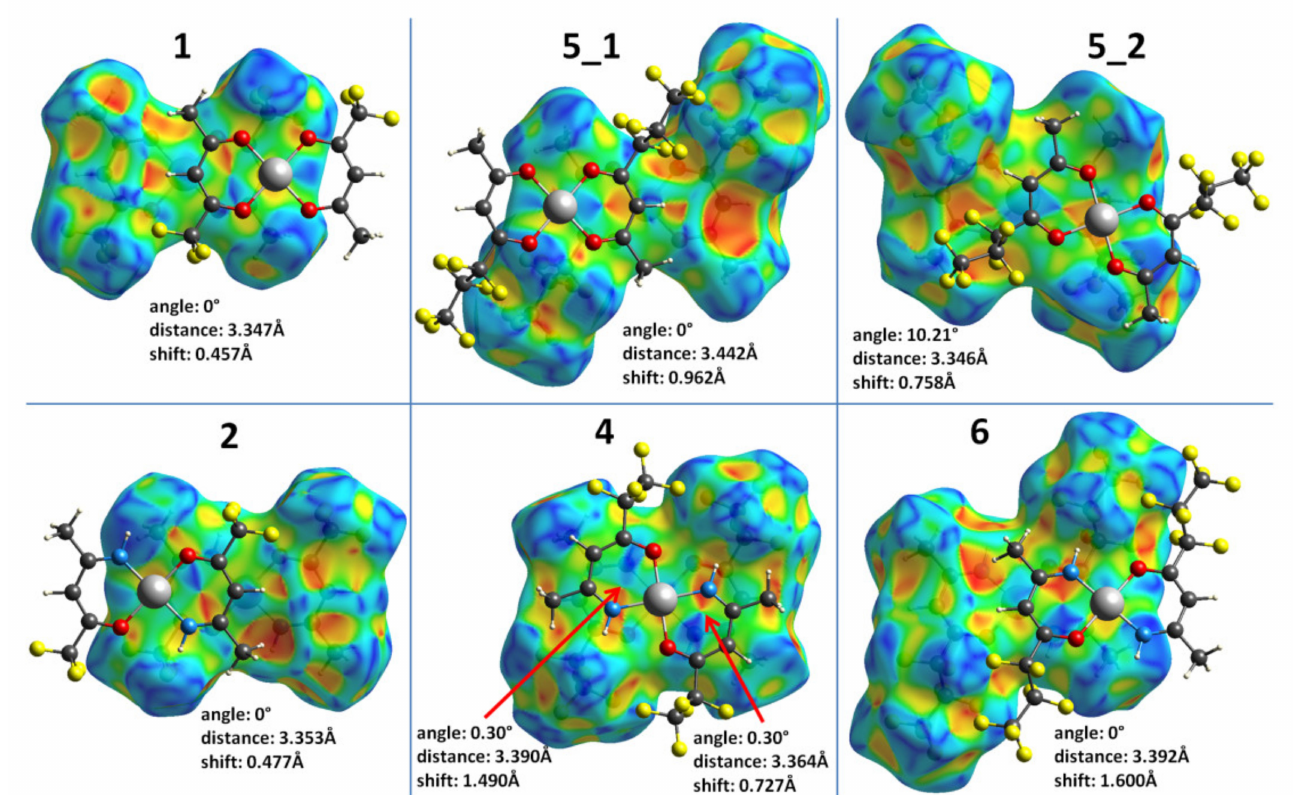
Figure 7. Hirshfeld surfaces for [Pd(CH 3 CXCHCO(R)) 2 ] complexes, mapped with the shape index property (range − 1 to